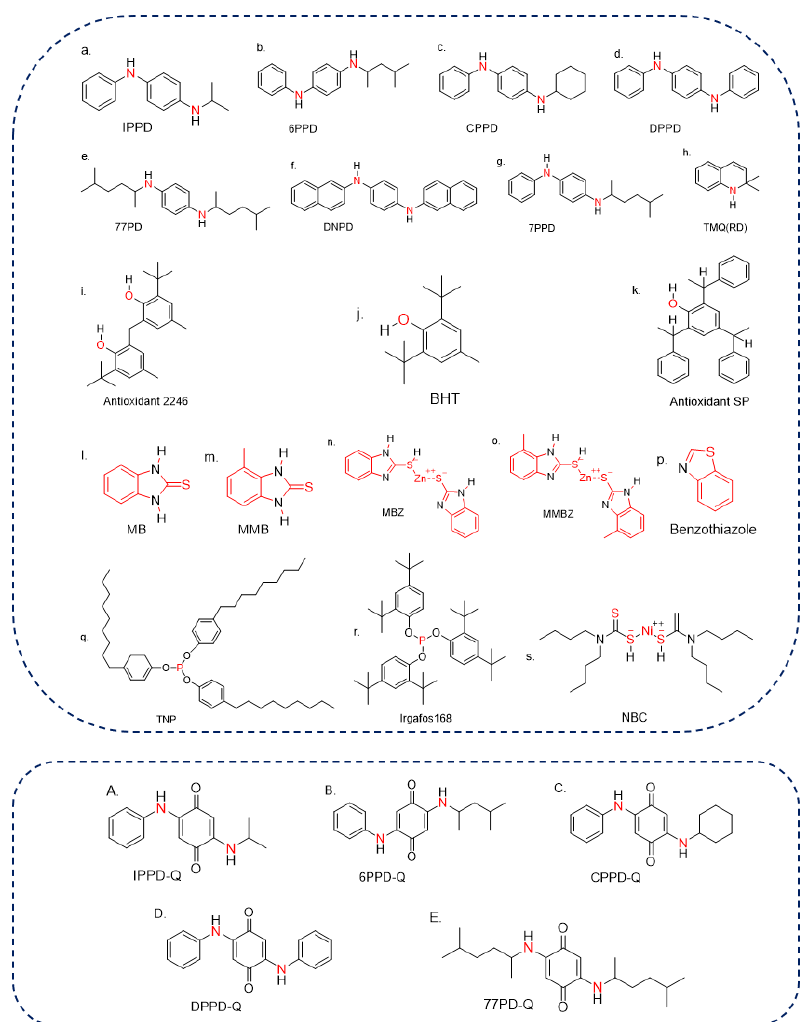
Figure 1. The structures of typical antioxidants and some of their TPs (( a – h ) are for amine antioxidants, ( i – k ) are for phenolic antioxidants, ( l – p ) are for heterocyclic antioxidants, ( q , r ) are for phosphite antioxidants, ( s ) is for nickel salts antioxidants, ( A – E ) are for TPs, the red parts represent the similar structure of the same type of